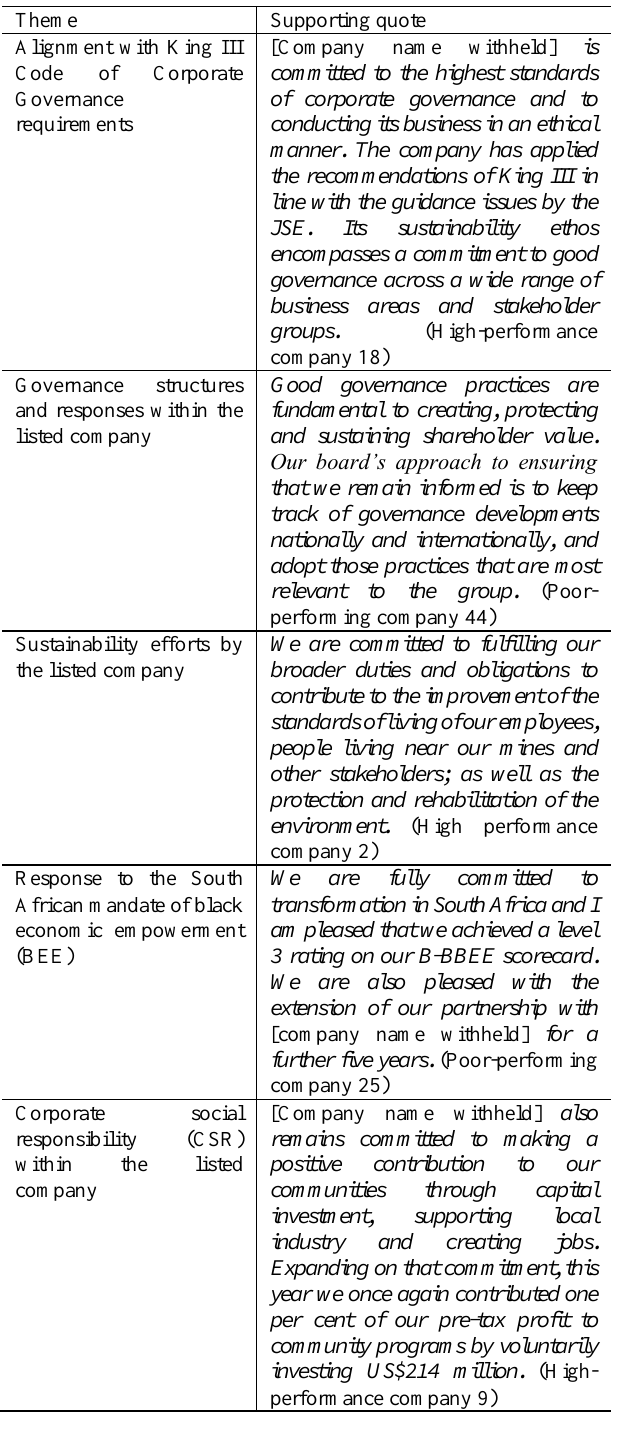
Table 2: Themes supporting governance